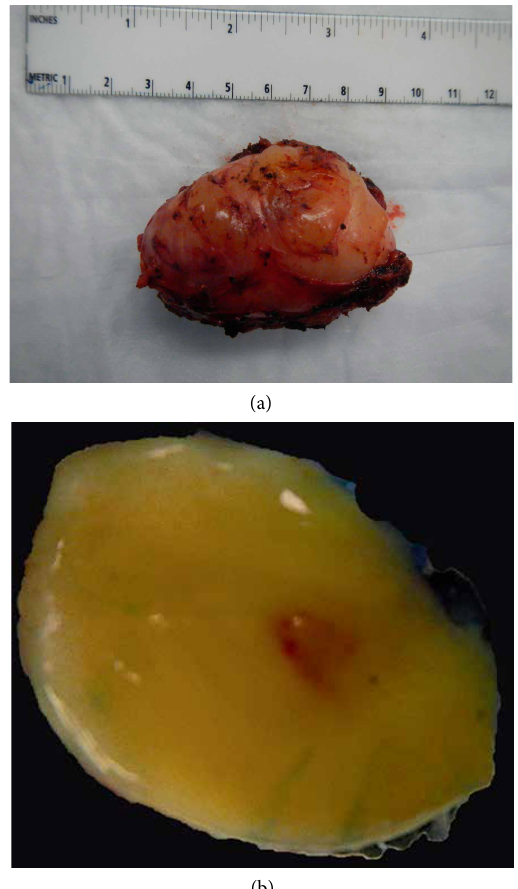
Figure 2: (a) Well circumscribed, ovoid mass. (b) Yellow, smooth and glistening cut surface.